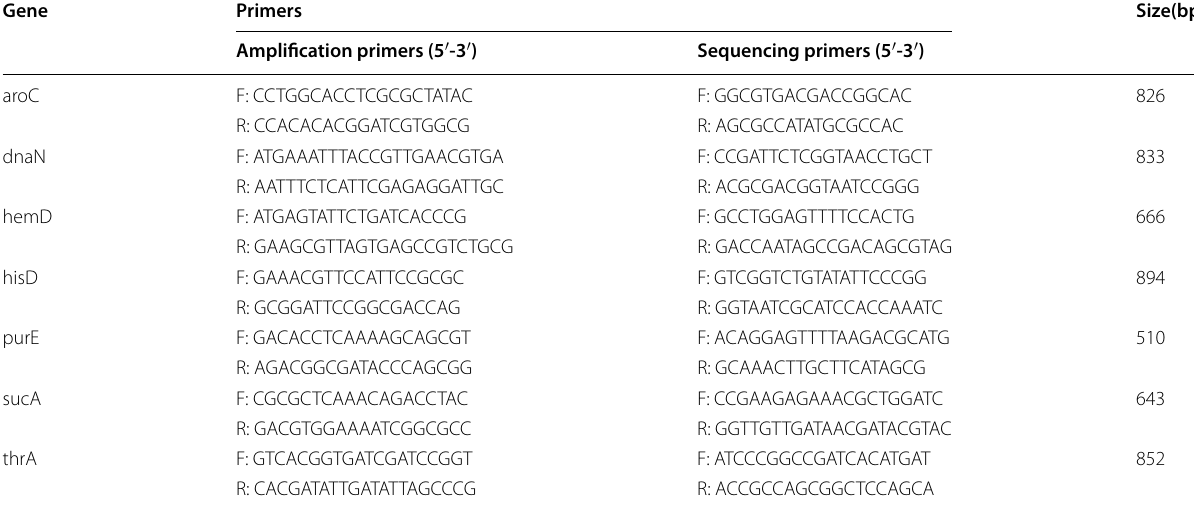
Table 1 Sequencing and amplification primers for Salmonella MLST typing